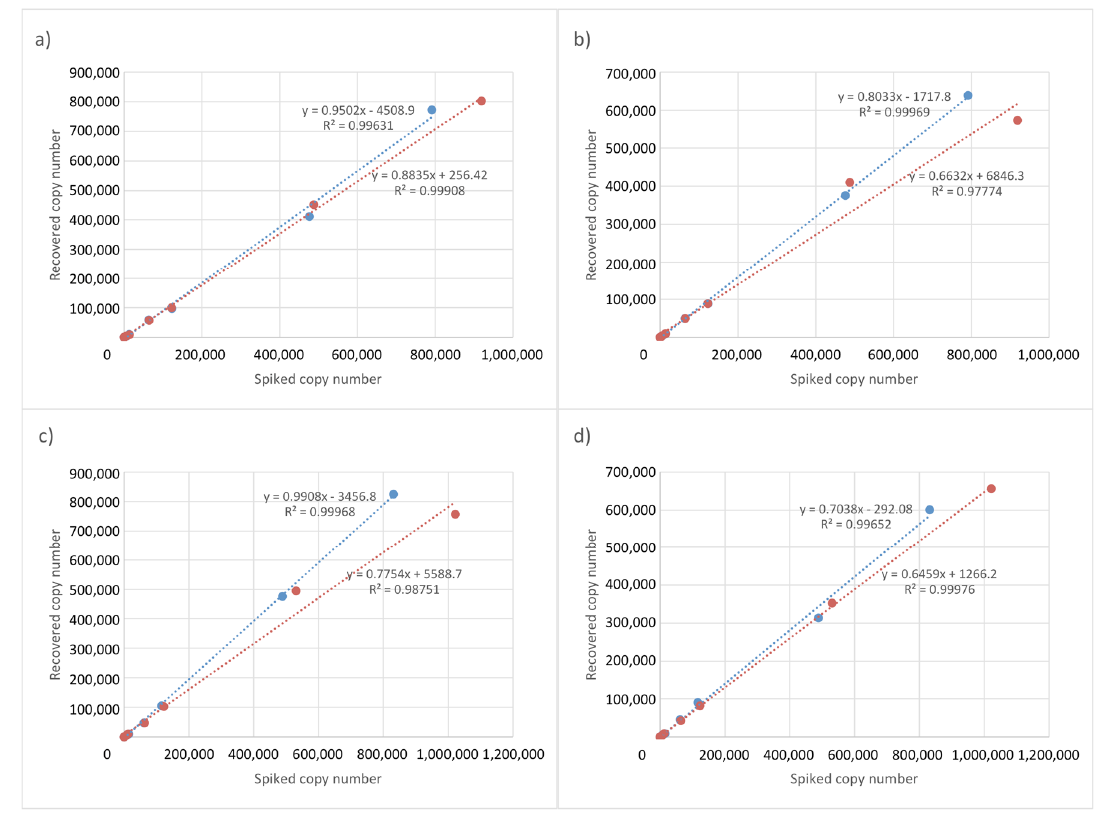
Figure 3. Efficient and quantitative recovery using samples extracted from plasma and urine. ( a ) Plasma and ( b ) urine samples in EDTA collection tubes at day 1 and ( c ) plasma and ( d ) urine samples at day 2. Blue circles denote SET1, and red circles denote SET2. The horizontal axis shows the spiked copy number in 1 mL of plasma and urine, respectively, and the vertical axis shows copy numbers recovered from plasma and urine, respectively. The slope indicates the recovery rate.